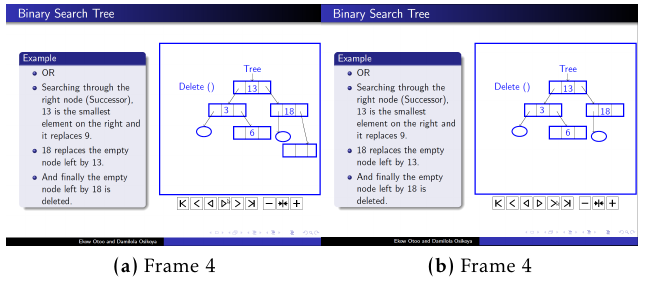
Figure 13. (Insert Operations in a Binary Tree) leaving its node empty. Element 18 replaces the empty node left by 13 and the empty node left by element 18 is